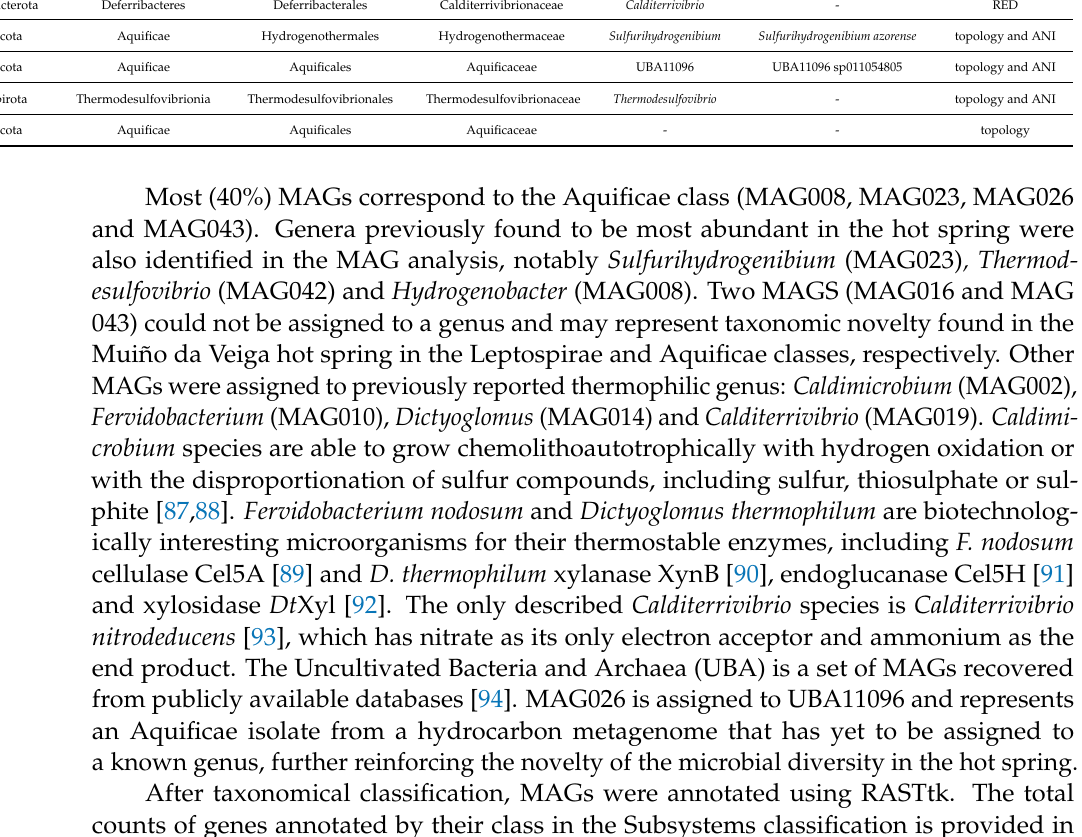
Metabolism” and “Nitrogen Metabolism” is provided in Figure